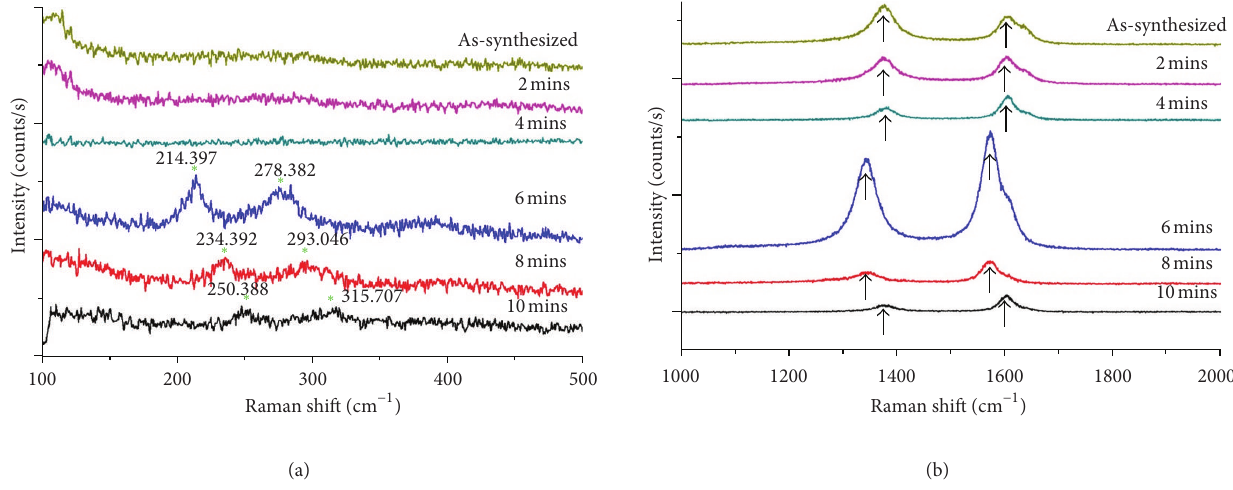
F 3: Micro-Raman spectra of camphoric-CNT grown by two-stage catalytic CVD at different thermal annealing time for the